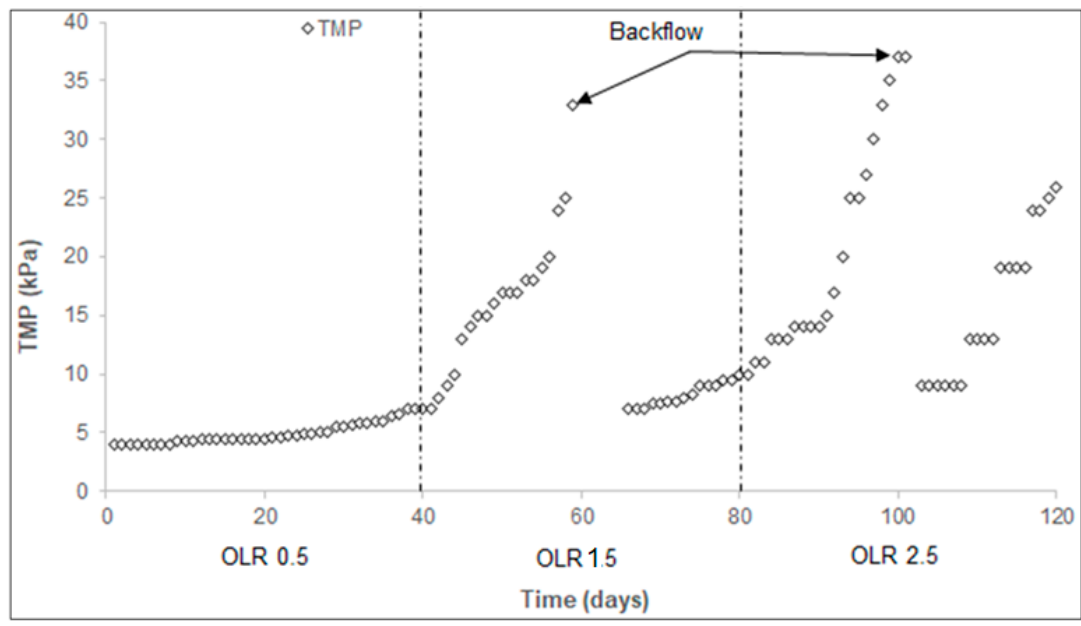
Figure 9. Transmembrane pressure (TMP) over time of MF membrane filtration in aerobic tanks.